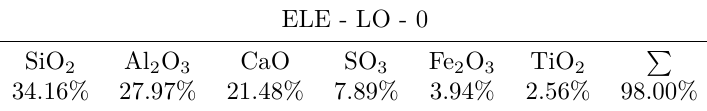
Table 5. XRF - chemical composition of fly ash ELE - LO.